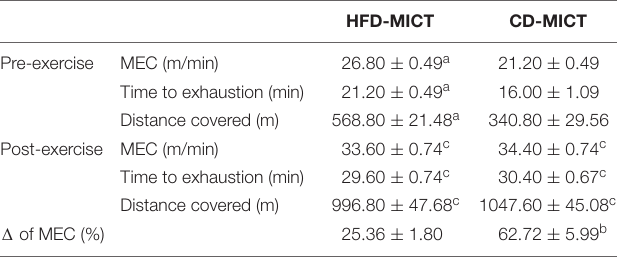
TABLE 3 | Variables of